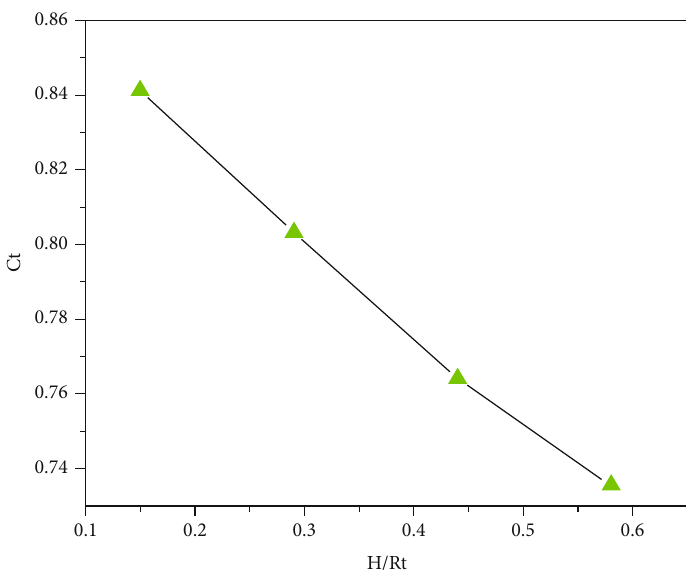
Figure 12: Thrust coe ffi cients for diverse rod penetration heights ( NPR = 4 : 6 and X